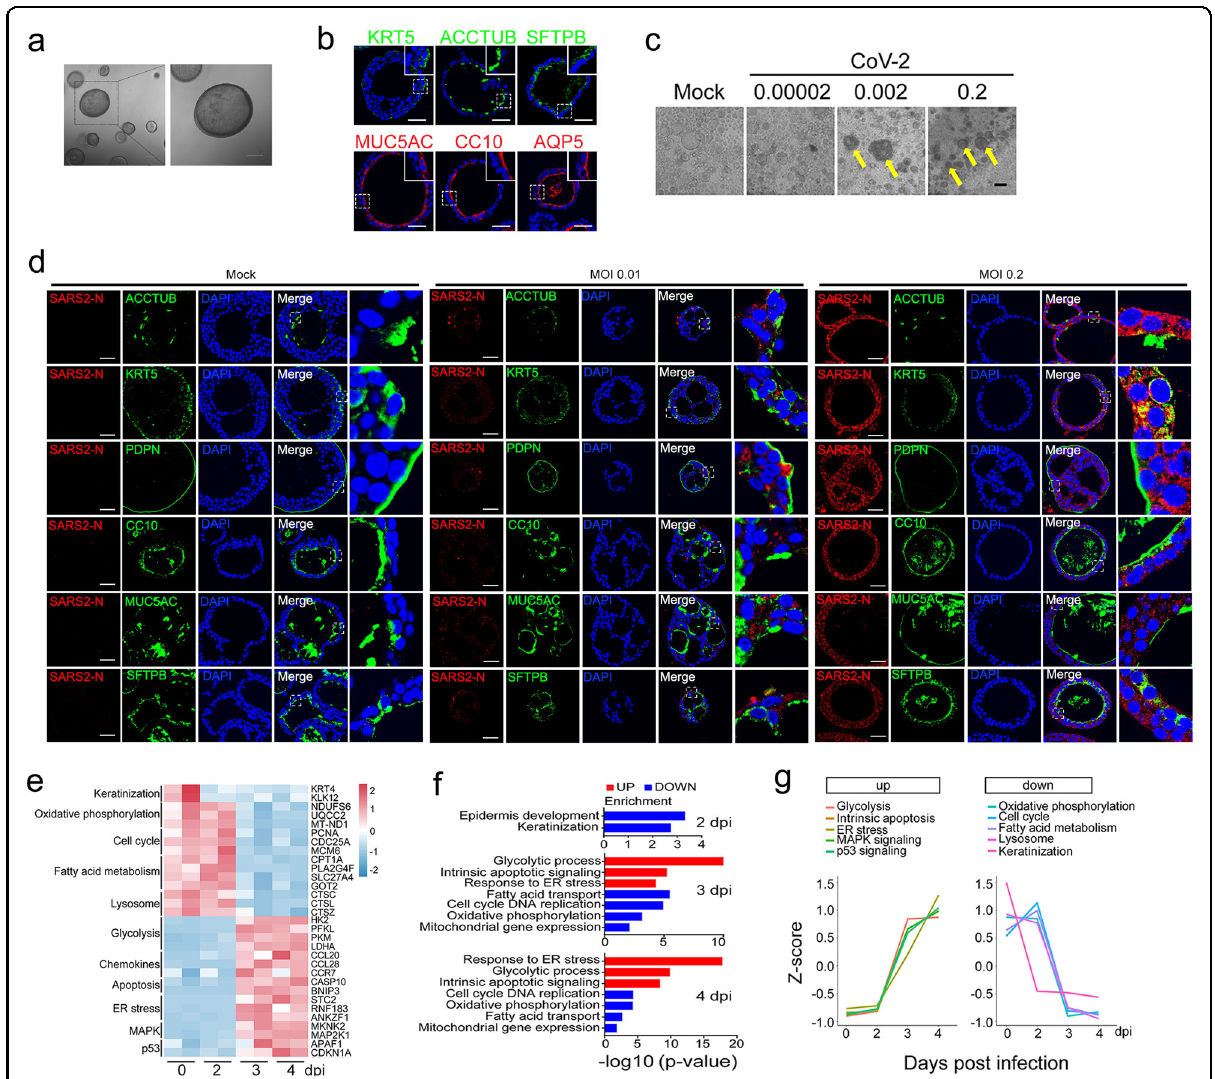
Fig. 1 SARS-CoV-2 infection of human distal lung organoids and its serial cellular responses. a Representative microscopy images of tissue- derived hDLOs. Scale bar, 100 μ m. b Immuno fl uorescence staining of different cell markers in hDLOs. Scale bar, 50 μ m. c Representative images of hDLOs upon SARS-CoV-2 infection at 3 dpi with indicated MOIs. Yellow arrows indicate the cytopathic organoids caused by SARS-CoV-2. Scale bar, 100 μ m. d Immuno fl uorescence staining of different cell markers and SARS-CoV-2-N antibodies in mock or SARS-CoV-2-infected hDLOs at 3 dpi at MOI = 0.01 and 0.2. Scale bar, 50 μ m. The data were repeated for three times. e Heatmap of differentially expressed genes in SARS-CoV-2-infected hDLOs compared to mock infection. f GO analysis of differentially expressed genes in SARS-CoV-2-infected hDLOs at 2, 3, and 4 dpi. The x -axis represents − log10 ( P value) for the enrichment analysis. g Variation trends of main pathways along different time points were